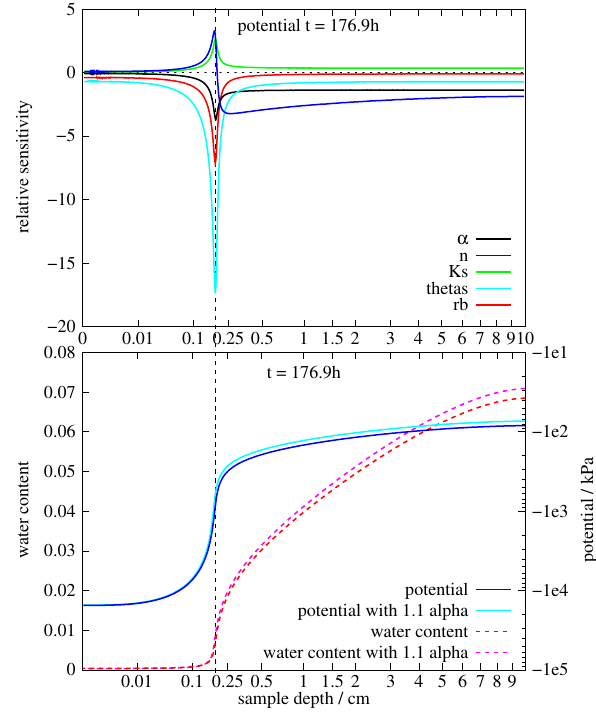
Fig. 11. Relative sensitivity s(z,t) of the potential ψ m on all vari- ables at t = 176 . 9h (top). The potential and water content pro- files for the undisturbed parameters as well as with α changed by 10% (bottom) illustrate the source of the huge sensitivity peaks at z ≈ 0 . 15cm in the plot above, the location is marked with a dotted vertical line. Note the non-linear scaling of the depth